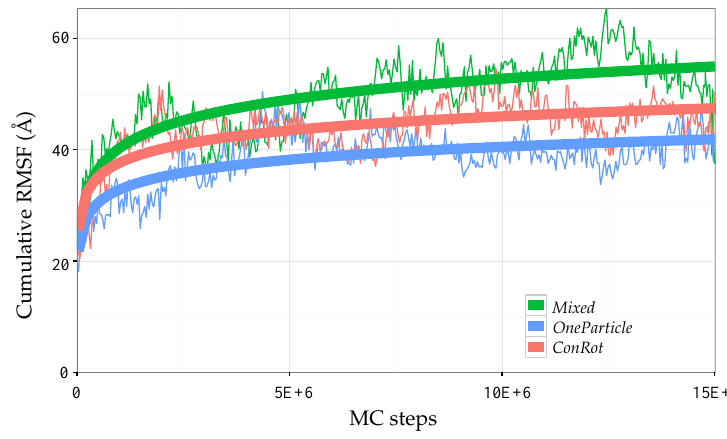
Figure 9. Evolution of the cumulative C α RMSF of ubiquitin with the number of MC steps using ConRot , OneParticle , and Mixed move classes.